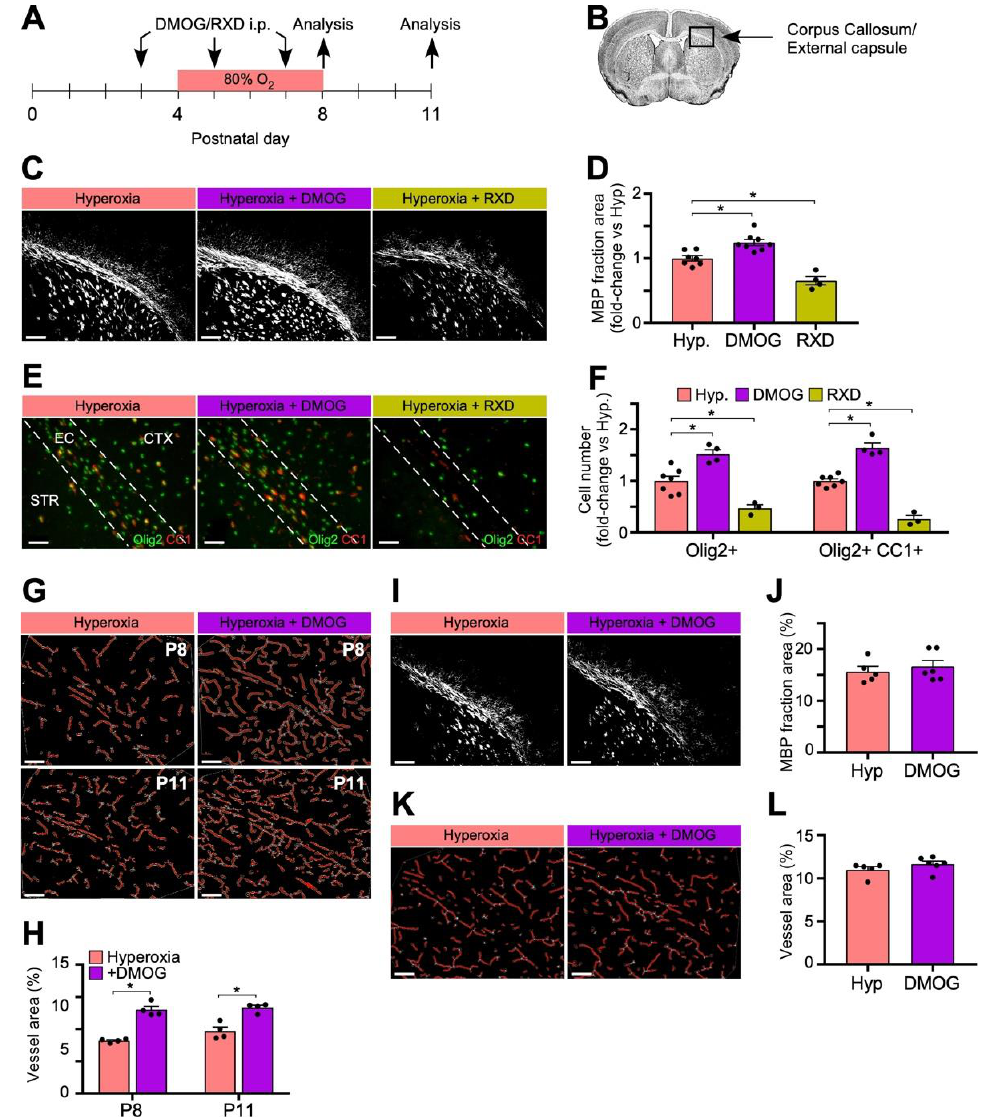
Figure 5. Systemic HIF-stabilization decreases and hepatic HIF stabilization increases myelination, oligodendrocyte populations, and vascular density at P11. ( A ) Schema demonstrating hyperoxia and HIF stabilization protocols. Mice were injected IP with DMOG (200 mg/kg) or Roxadustat (RXD) (10 mg/kg) at P3, P5, and P7 and placed in 80% oxygen from P4 to P8. ( B ) Areas that were imaged in the Corpus Callosum/External capsule. ( C ) Representative fluorescent images (5×) of myelin basic protein (MBP) immunohistochemical staining at each time point after applying consistent exposure and threshold parameters between groups during imaging and analysis. Scale bar = 200 μ m. ( D ) Quantification of MBP immunofluorescence as mean percent area normalized to hyperoxia shows increased MBP staining after DMOG and decreased MBP staining after Roxadustat, imaged at P11. ( E ) Fluorescent images (20×) showed increased Olig2+ (green) and Olig2+CC1+ (green and red) oligodendrocytes after DMOG and decreased numbers after Roxadustat in the corpus callosum. Scale bar = 50 μ m. ( F ) Quantification of Olig2+ and Olig2+CC1+ at P11. ( G ) Representative images of brain capillary networks supplying the EC stained with lectin and analyzed by AngioTool. Scale bar = 100 μ m. ( H ) Quantification of mean vessel area demonstrates increases following hyperoxia at both P8 and P11 in the DMOG group. ( I ) Representative images of immunofluorescent MBP in the corpus callosum shows no difference in the hepatic HIF-1 KO. Scale bar = 200 μ m. ( J ) Quantification of MBP comparing DMOG treatment in the hepatic HIF-1 KO. ( K ) Representative brain capillary images from the hepatic HIF-1 KO with and without DMOG treatment. Scale bar = 100 μ m. ( L ) Quantification of brain capillary density shows no effect of DMOG in the hepatic HIF-1 KO. No difference in MBP in the hepatic HIF-1 KO demonstrates that DMOG induced protection is dependent on hepatic